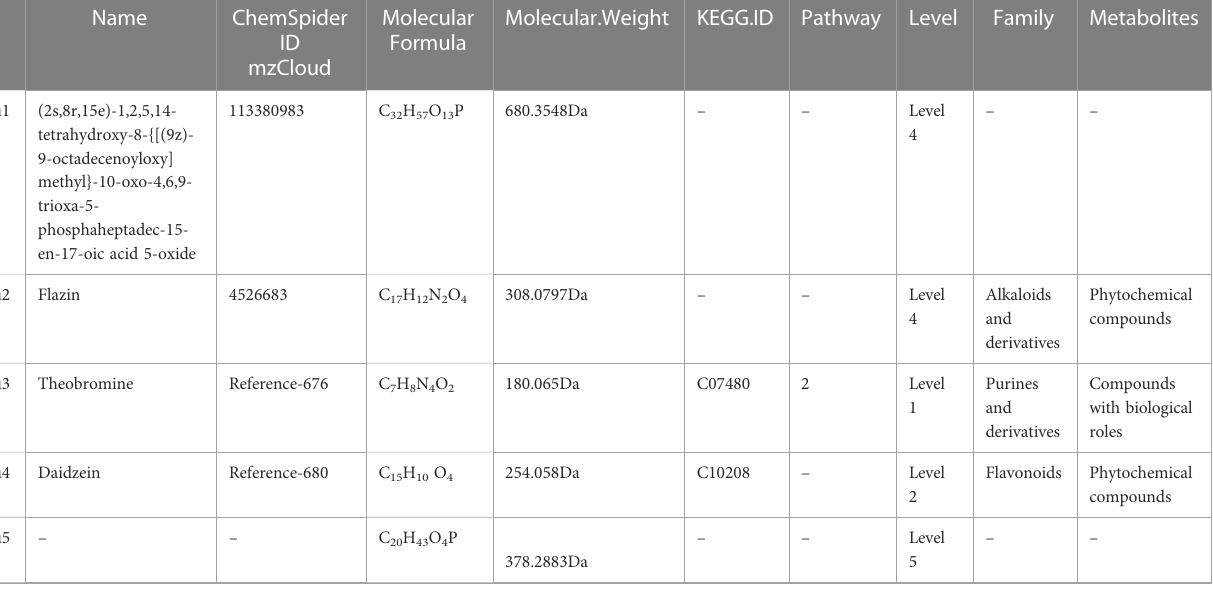
TABLE 4 Detailed information about top 5 (pu1-pu5) up-regulated and top 5 (pd1-pd5) down-regulated differential metabolites in the positive ion